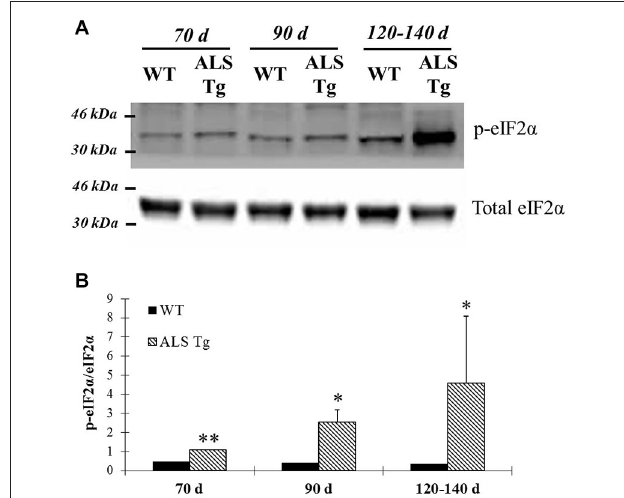
FIGURE 2 | Phosphorylation of eIF2 α is up-regulated in skeletal muscle of G93A*SOD1 ALS-Tg mice . (A) Total protein from WG muscle tissues was isolated from wild-type (WT) and transgenic G93A*SOD1 (ALS-Tg) mice. Western blots showed phospho-eIF2 α (Ser51) and total eIF2 α . Three different disease stages were used: early pre-symptomatic (70d; n = 3 each for WT and ALS-Tg), late pre-symptomatic (90d; n = 5 each for WT and ALS-Tg), and symptomatic (120–140d; n = 3 each for WT and ALS-Tg) mice. (B) Analysis of ratio of phospho-eIF2 α to total eIF2 α . Data in (B) is presented as mean ±